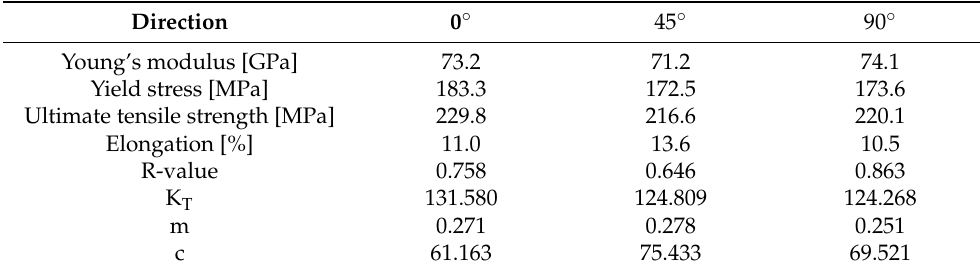
Table 1. Mechanical properties of